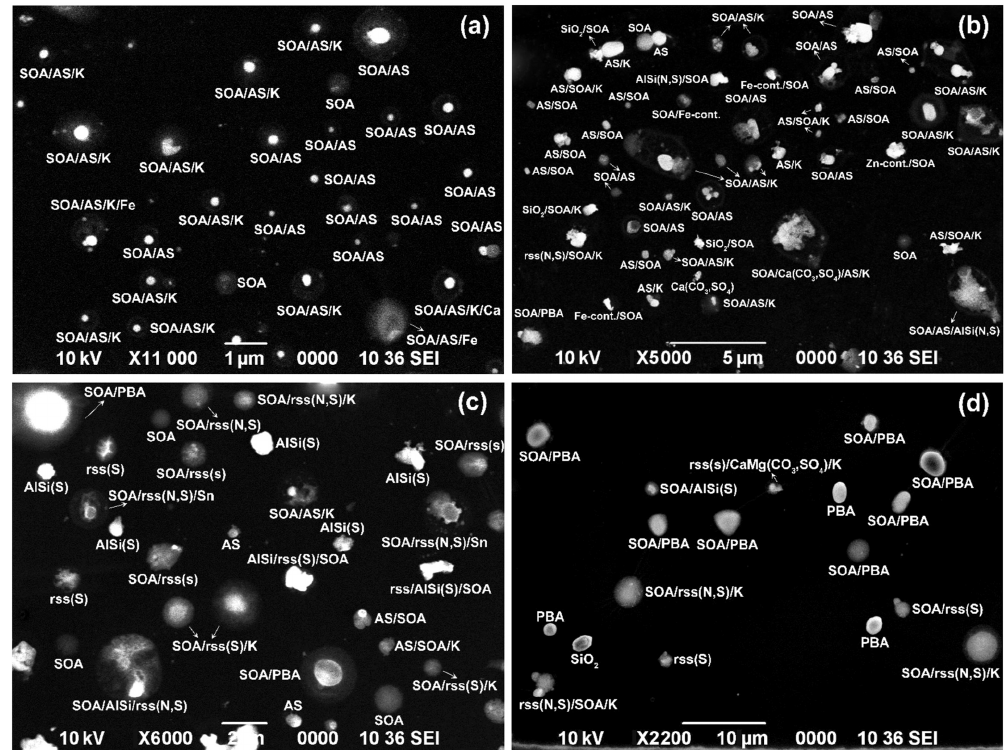
Figure 4. Typical SEM images of aerosol particles for (a) stage 1 (PM 0 . 25 − 0 . 5 ) of the SA2 sample, (b) stage 2 (PM 0 . 5 − 1 . 0 ) of the SA4 sam- ple, (c) stage 3 (PM 1 − 2 ) of the SA1 sample, and (d) stage 4 (PM 2 . 0 − 4 . 0 ) of the SA4 sample, collected at the ATTO site. For convenience, ammonium sulfate, secondary organic aerosol, aluminosilicates, and reacted sea salt are denoted as “AS”, “SOA”, “AlSi”, and “rss”, respec-